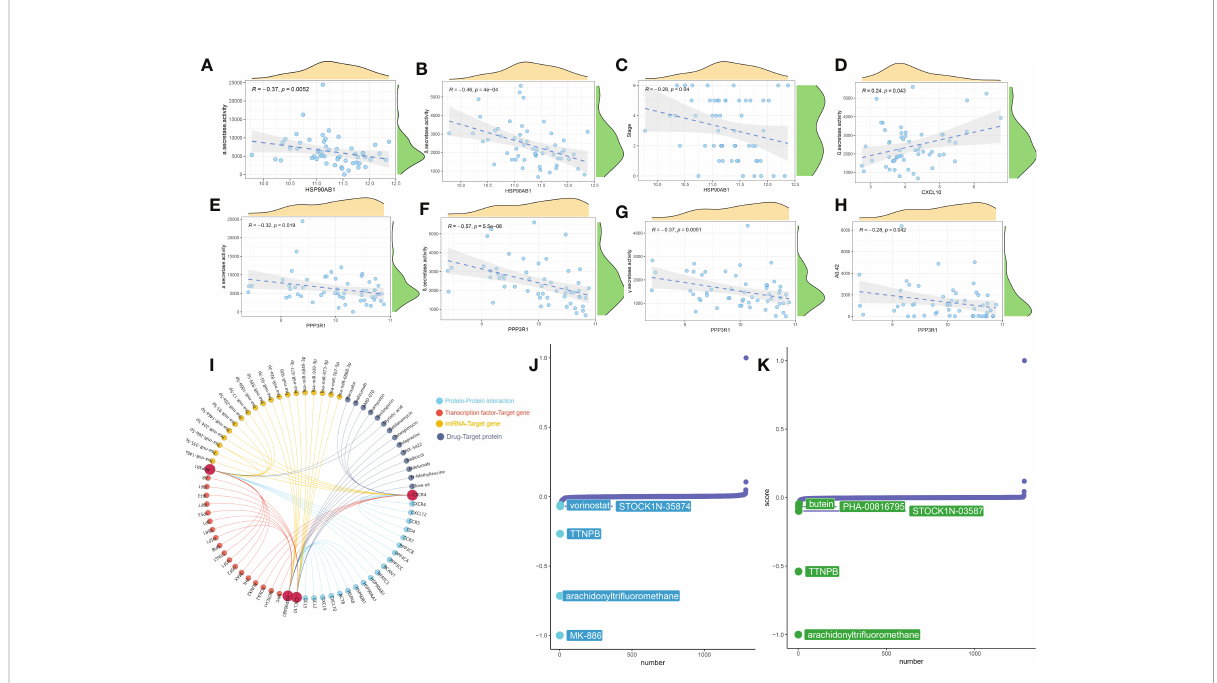
FIGURE 11 Correlation analysis and therapeutic target prediction. (A – H) Scatter plot showing the correlations between HSP90AB1, CXCL10, PPP3R1 and AD pathological markers ( a -secretase activity, b -secretase activity, AD clinical stag, and A b -42 levels). (I) Prediction of upstream- or downstream- target molecules of 5 signature genes including protein-protein interaction, transcription factors, miRNA, and potential drugs. (J, K) CMap analysis revealing the potential therapeutic drugs for subtype1 (J) and subtype2 (K) ,